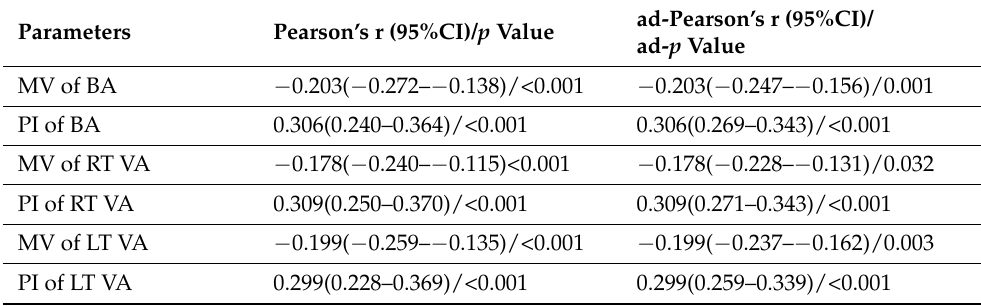
Table 2. Correlation of sonographic parameters of VAs and BA to age. Parameters